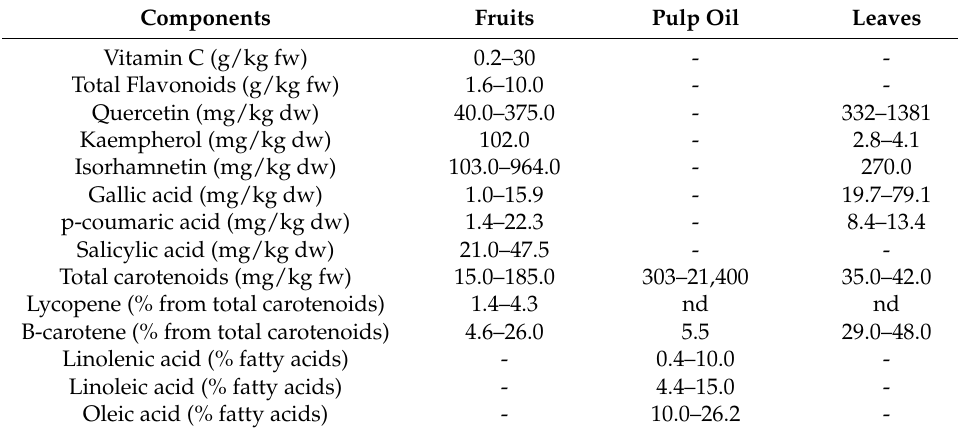
Table 1. Composition of sea